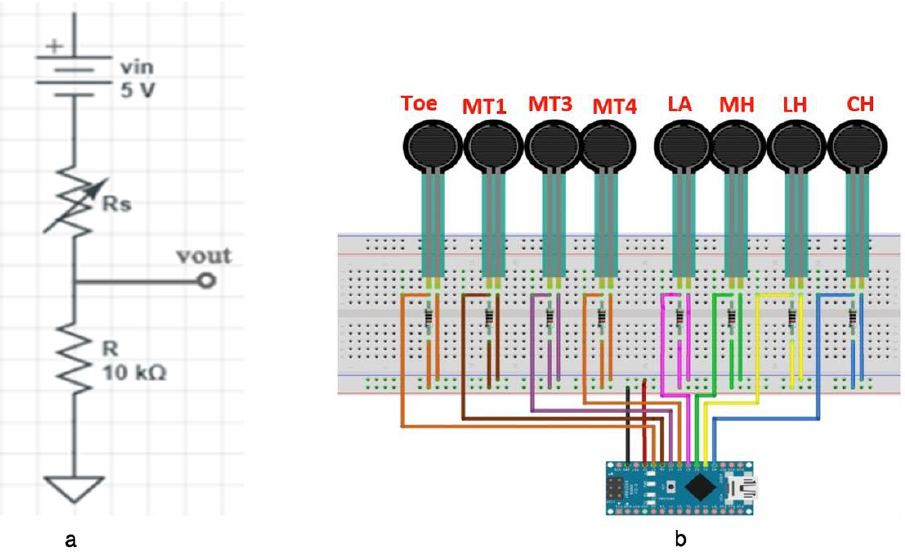
Figure 4. The exact locations of the sensors on the insole.